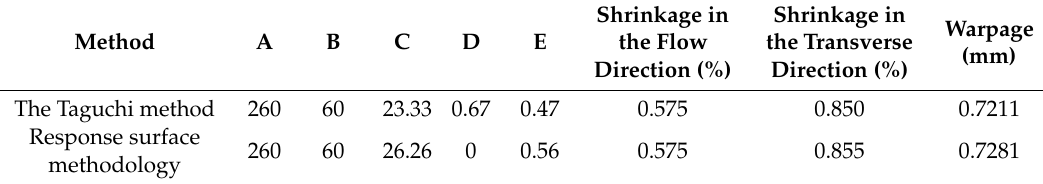
Table 10. Comparison of optimum